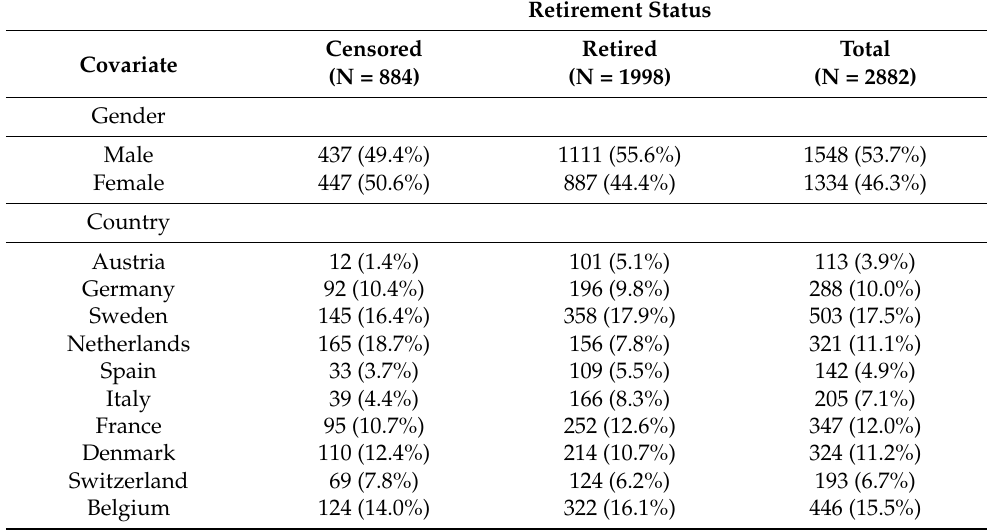
Table 3. Descriptive analysis of covariates, by survival status at the end of the observation period (N =